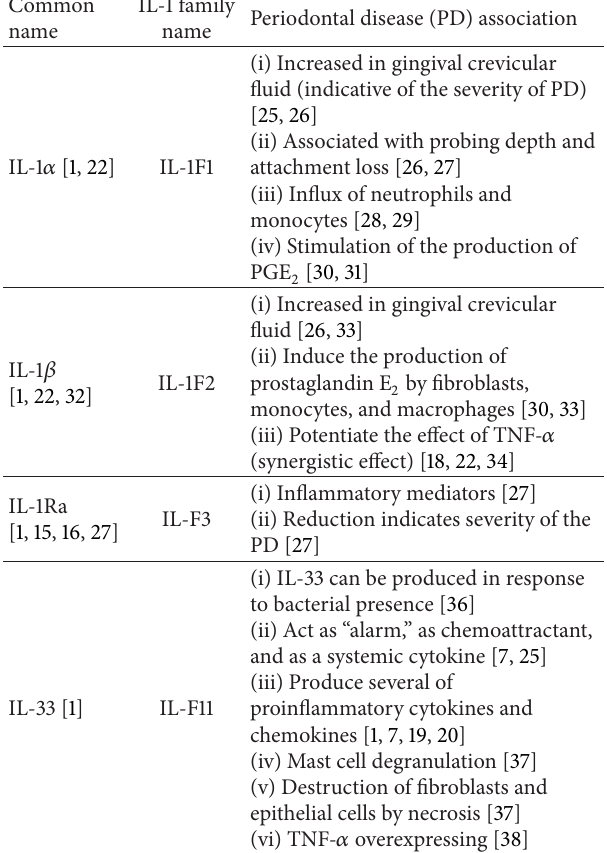
Table 2: Role of IL-1 cytokine family members in periodontal